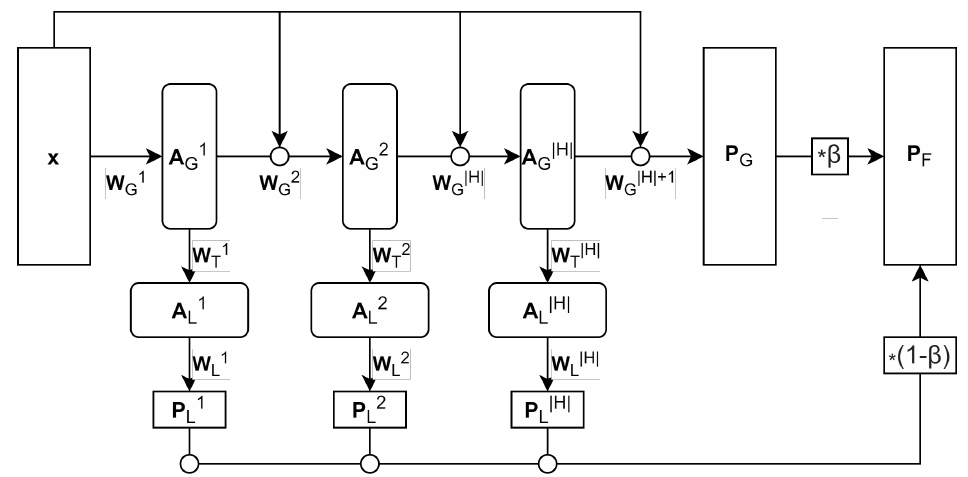
Figure 7. Overview of hierarchical variant of a model, inspired by